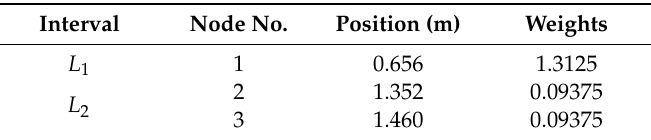
Table 4. Node reconstruction configuration scheme.